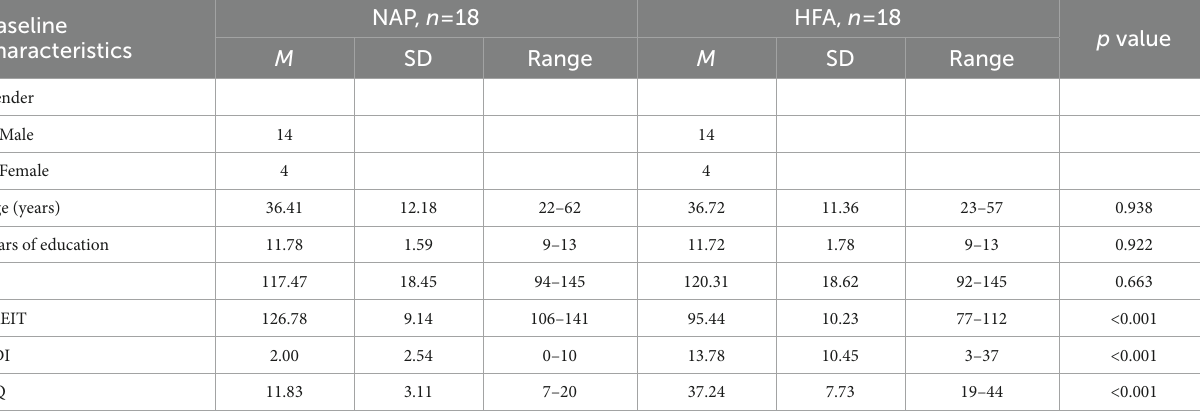
TABLE 1 Participant characteristics. Baseline